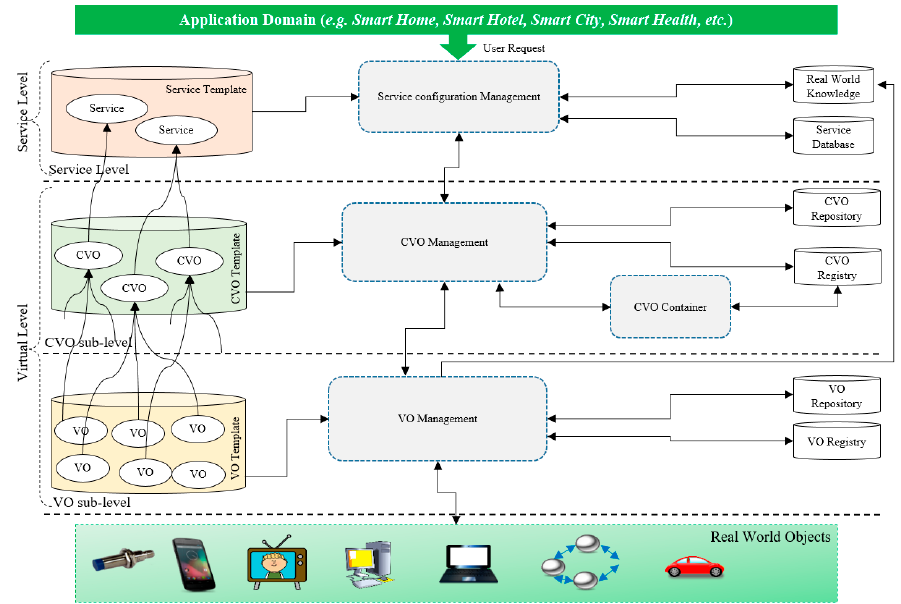
Figure 2. Functional entities and layer architecture of the Web of Objects platform [1,2].